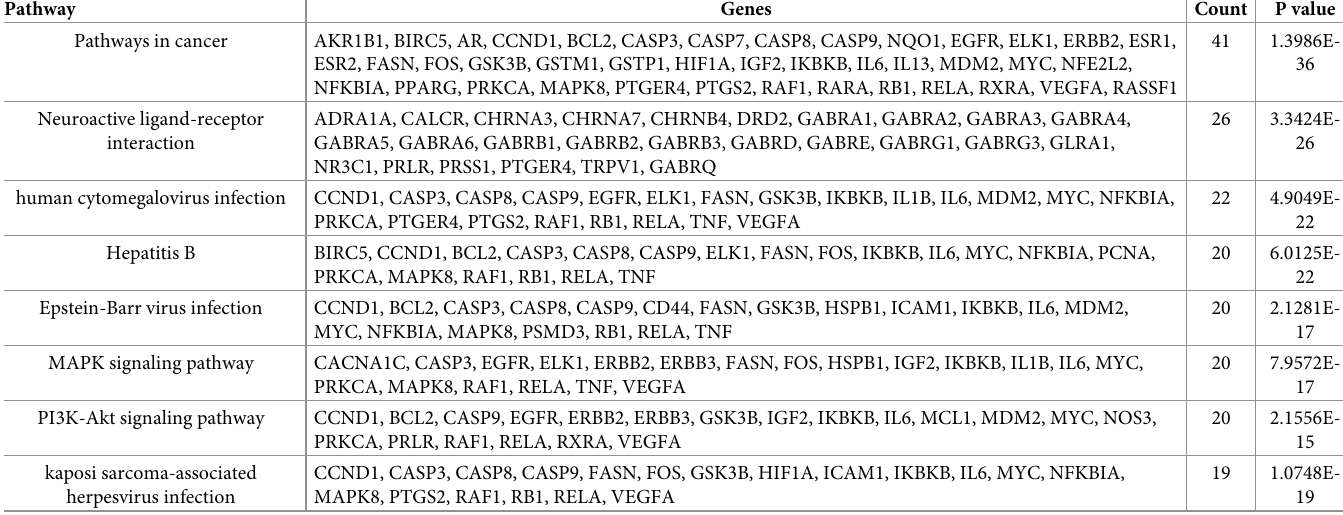
Table 4. KEGG pathway enrichment analysis based on the YSTLF-oligoasthenozoospermia network (top 20 with count). Pathway Genes Count P value Pathways in